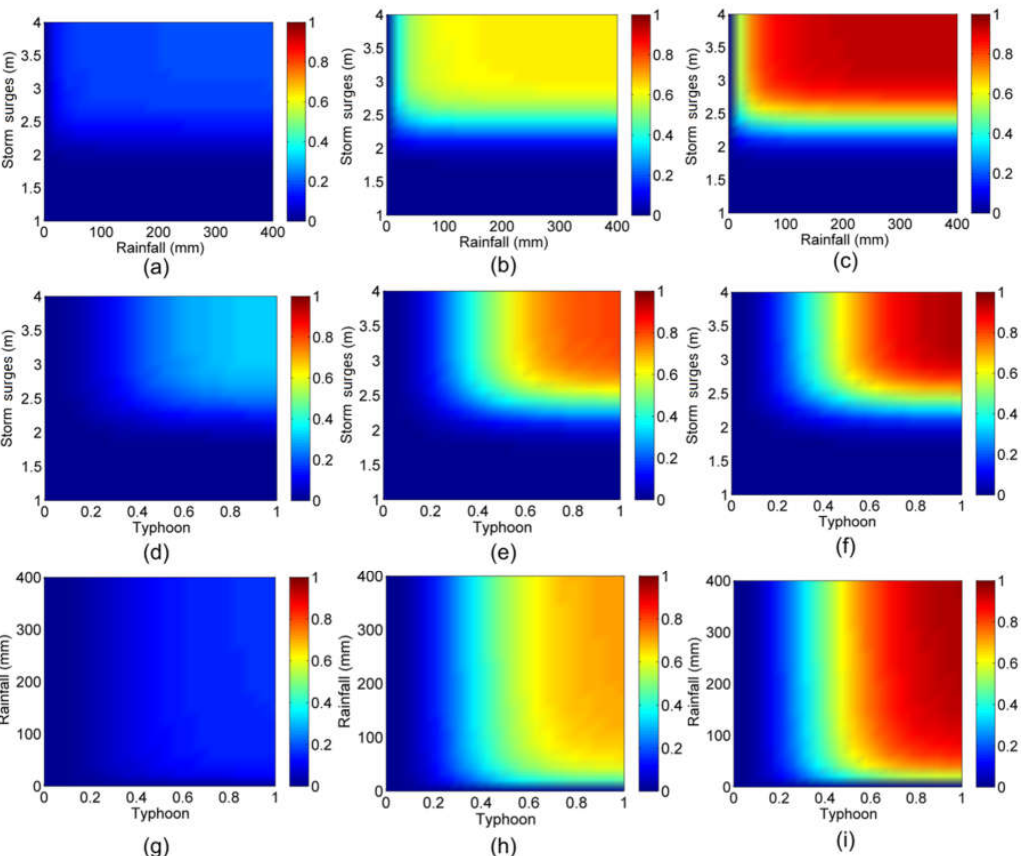
Figure 9. Some bivariate views of the trivariate probability distribution of typhoons, rainfall, and storm surges. Joint probability distribution of rainfall and storm surges when typhoon value is ( a ) 0.2, ( b ) 0.5, ( c ) 0.8; joint probability distribution of typhoons and storm surges when rainfall is ( d ) 10 mm, ( e ) 50 mm, ( f ) 150 mm; joint probability distribution of typhoons and rainfall when storm surge is ( g ) 2.0 m, ( h ) 2.5 m, ( i ) 3.0 m.